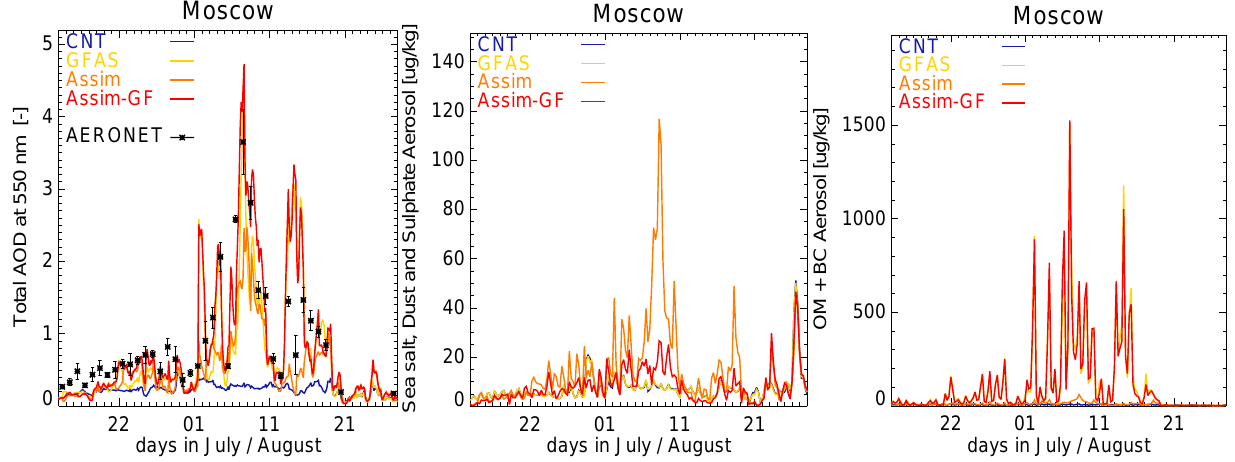
Fig. 4. Left) modeled total aerosol optical depth at D+0, compared to daily average AERONET observations at the Moscow station (black). The error bars reflect the daily variance in the available observations. Middle) total of seasalt, dust and sulphate aerosol, Right) total of organic matter and black carbon aerosol. Table 4. Mean bias and RMSE of modeled AOD compared to the measurements from AERONET station at Moscow, between 20 July and 15 August, as function of the hindcast